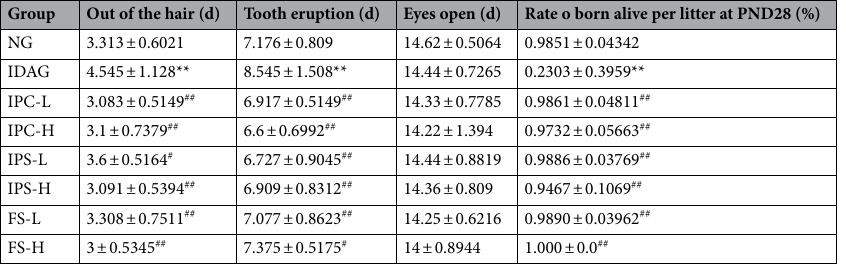
Table 3. The development and PND 28 survival of offspring rats. * p < 0.05, ** p < 0.01, compared with NG, # p < 0.05, ## p < 0.01, compared with IDAG. One-way ANOVA followed by Tukey multiple comparison test was used for comparison among 8 different groups.